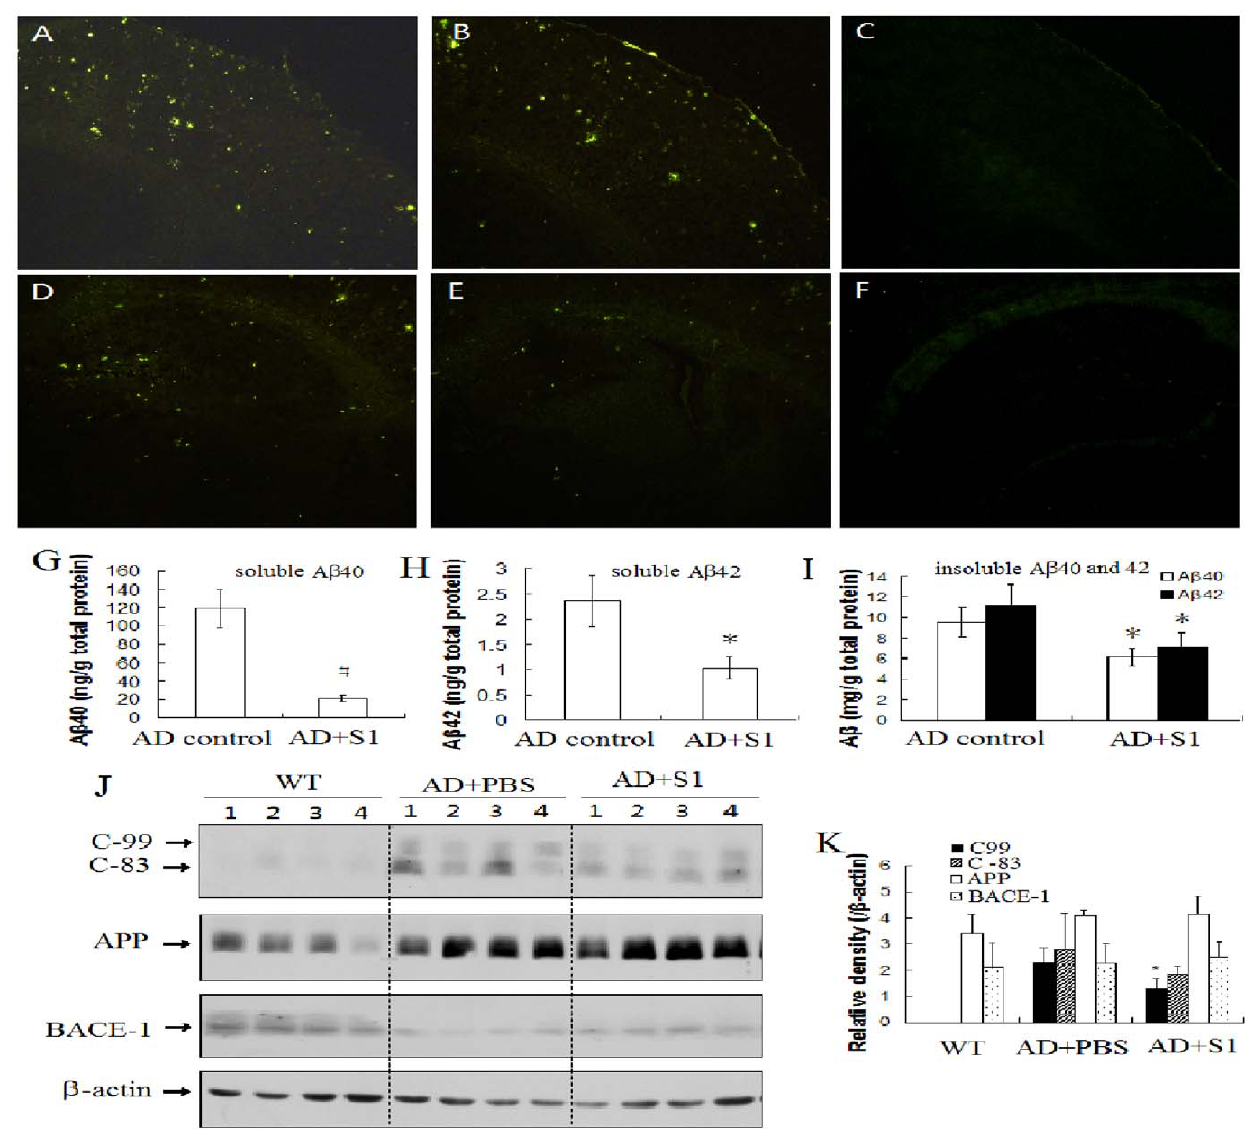
Figure 7. Effect of S1 on amyloid burden and A b levels in APP/PS1 transgenic mice. Brain sections were stained with ThS, and the images of the cortex (A, B, C) and hippocampus (D, E, F) of AD transgenic mice treated with vehicle (A, D) or S1 (B, E) and WT mice (C, F) were collected. The amounts of soluble A b 40 (G), soluble A b 42 (H) and insoluble A b 40 and A b 42 (I) in brain extracts were detected by sandwich ELISA using A b 40 and A b 42 immunoassay kits (compared with AD mice control, *, P , 0.05; # , P , 0.01). Brain extracts were analyzed by Western-blot using antibodies specific for C83, C99, APP and BACE-1, respectively. b -actin in all extracts was used as a loading control (J). The intensity of C99, C83, APP and BACE-1 immunoblots in (J) was quantified. Densitometry values are expressed as values relative to b -actin